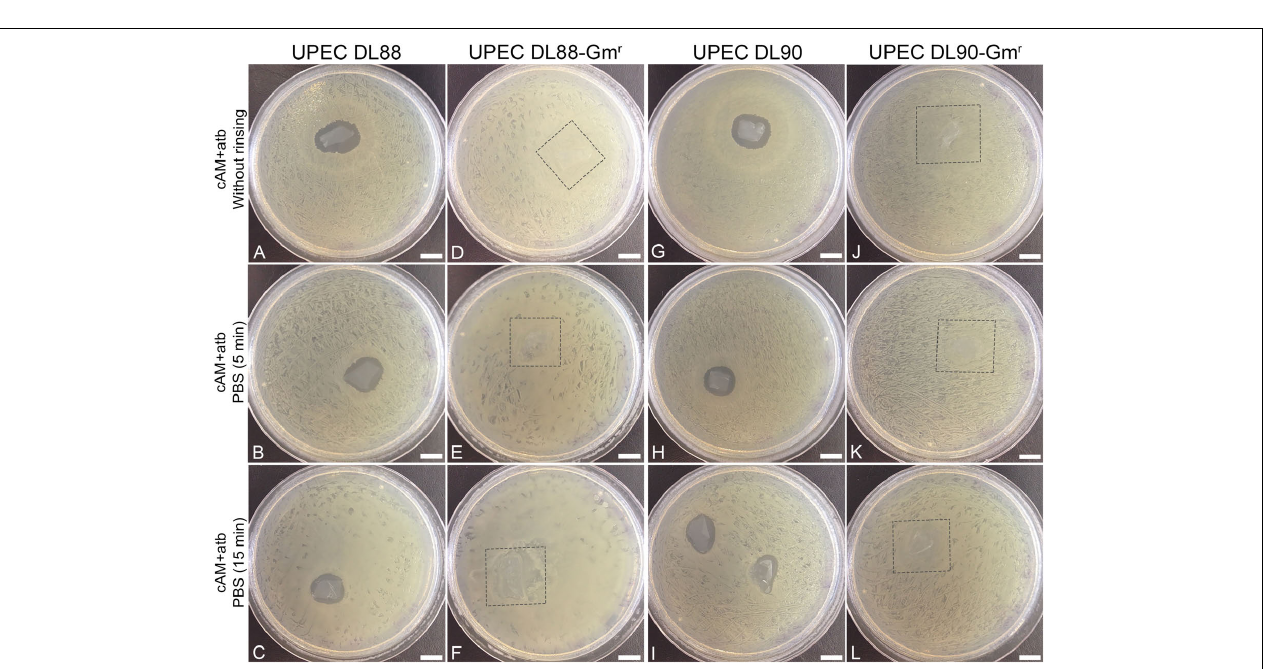
FIGURE 3 | Rinsing cAM + atb patches in phosphate-buffered saline (PBS) decreases the antimicrobial effect of cAM + atb patches on UPEC DL88 and UPEC DL90 strains. (A–C,G–I) Increased rinsing time of cAM + atb patches results in a decrease of antimicrobial zones in case of UPEC DL88 and UPEC DL90. (D–F,J–L) cAM + atb patches have no antimicrobial effect on UPEC DL88-Gm r and UPEC DL90-Gm r . These results were obtained by employing antimicrobial efficiency assay with AM patches on solid agar. Two independent replications of experiments using two biological samples were conducted and three technical repeats were performed for each condition. Square frame – the location of cAM + atb patch, overgrown with tested strain. Scale bars: 10 mm.